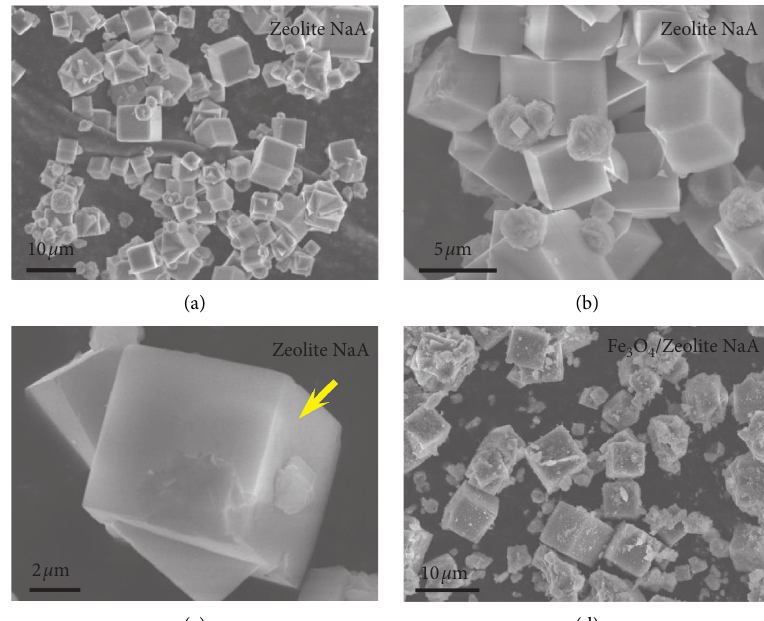
Figure 3: Micro-Raman spectra of zeolite A as-synthesized Fe 3 O 4 NPs and Fe 3 O 4 /ZA nanocomposite samples with different Fe 3 O 4 NP loadings (wt. %). The optical microscope images of the probed area (dash rectangles) are presented right next to their corresponding spectrum.